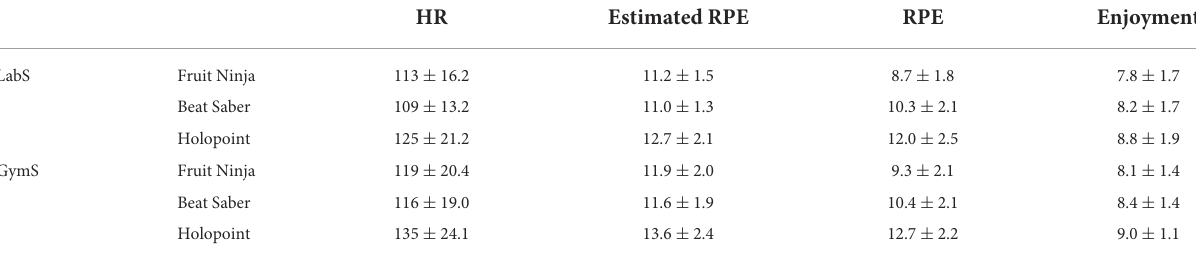
TABLE 3 Measures of physiological responses (heart rate, HR; estimated rating of perceived exertion, estimated RPE) and psychological responses (rating of perceived exertion, RPE; enjoyment) during active virtual reality gaming (AVRG) in different settings (Laboratory, LabS; Gym/Recreation Center,